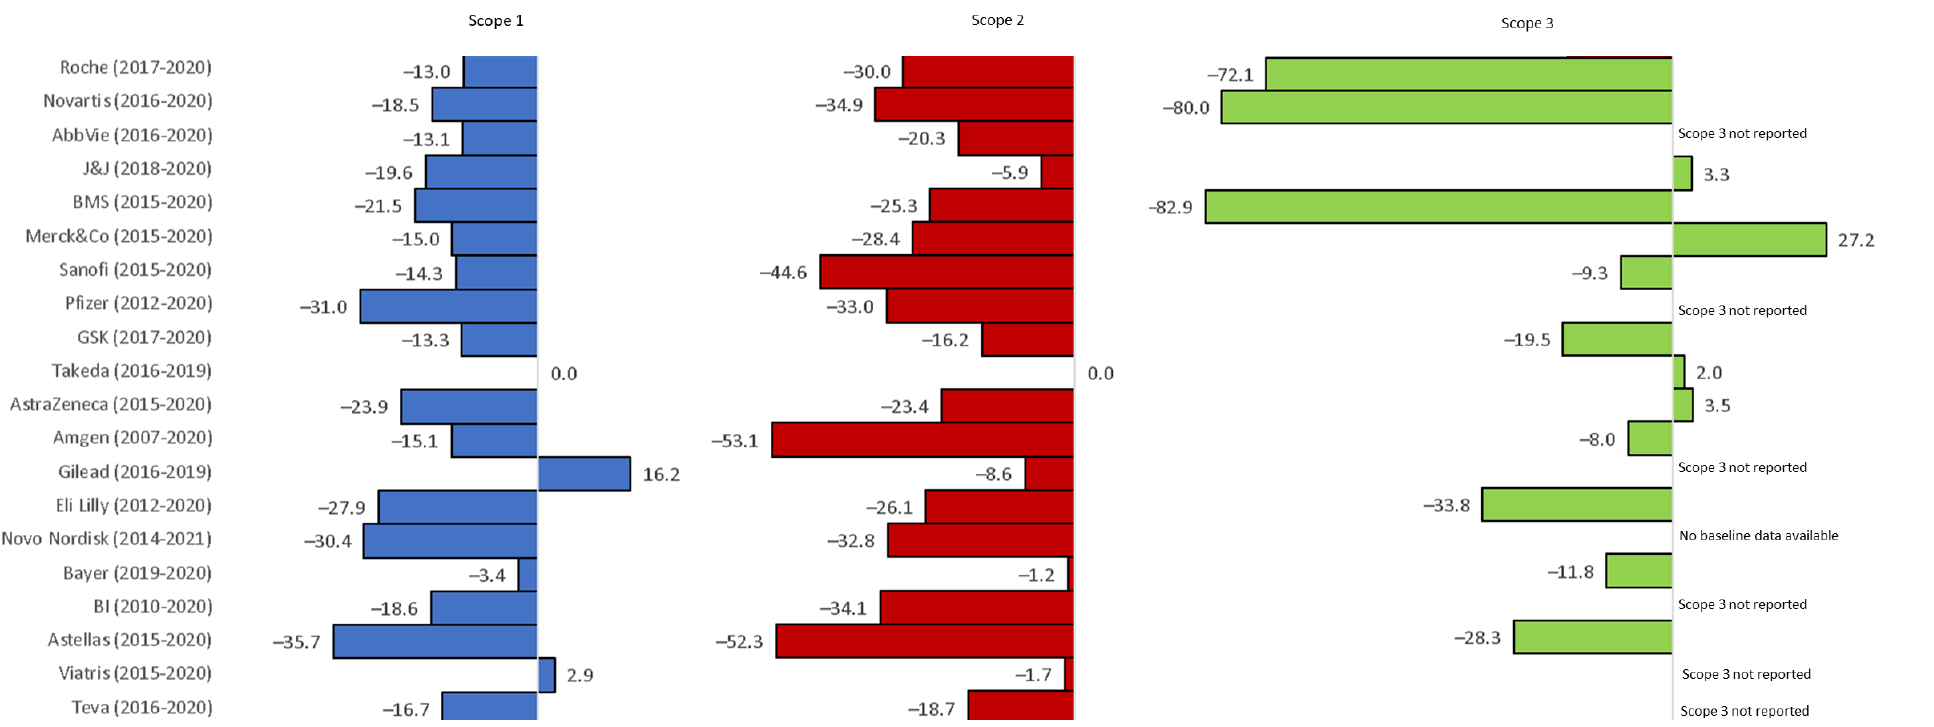
Figure 2. Percentage change over reporting period (in brackets) in company scope 1, 2, and 3 GHG emissions (Roche, Novartis, and BMS only reported business travel/flights in scope 3 emissions).